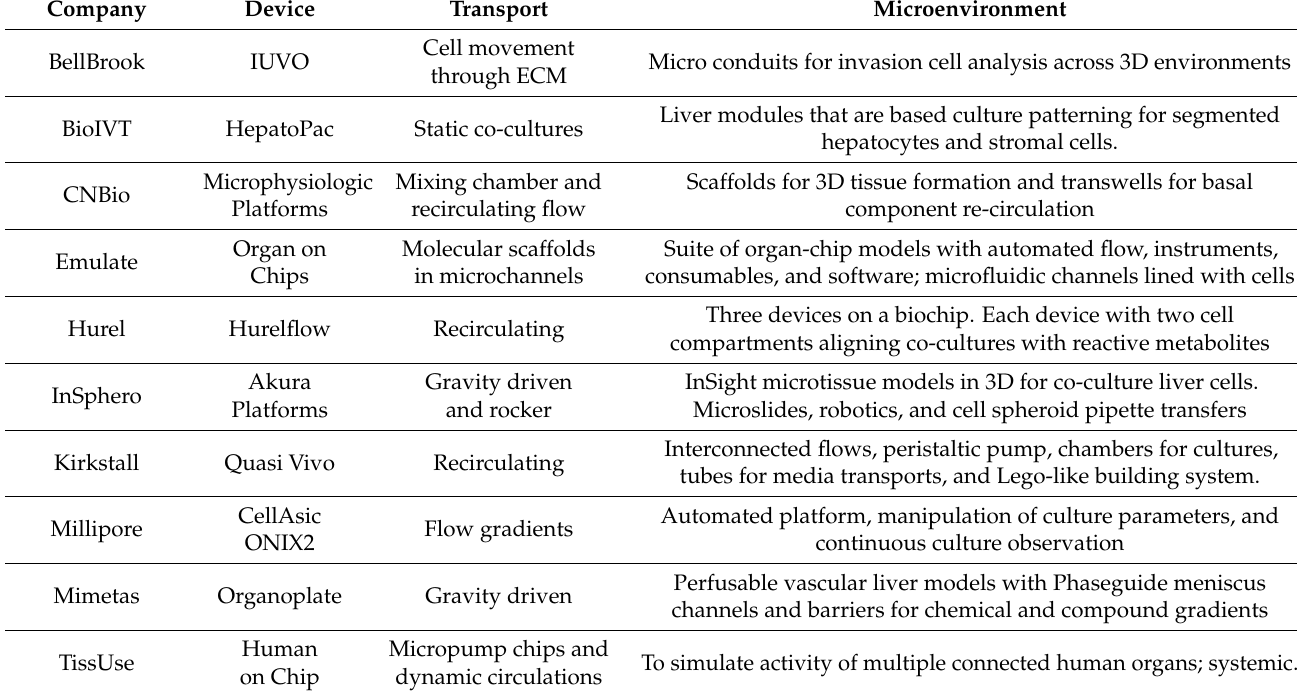
Table 10. µ Fluidic contemporary technologies with fit-for-purpose